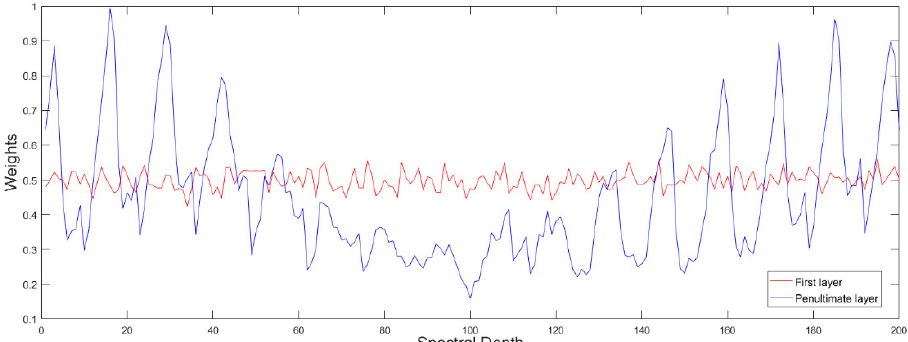
Figure 11. Average weights generated by spectral-wise attention mechanism on first layer and penultimate layer on Indian Pines dataset.